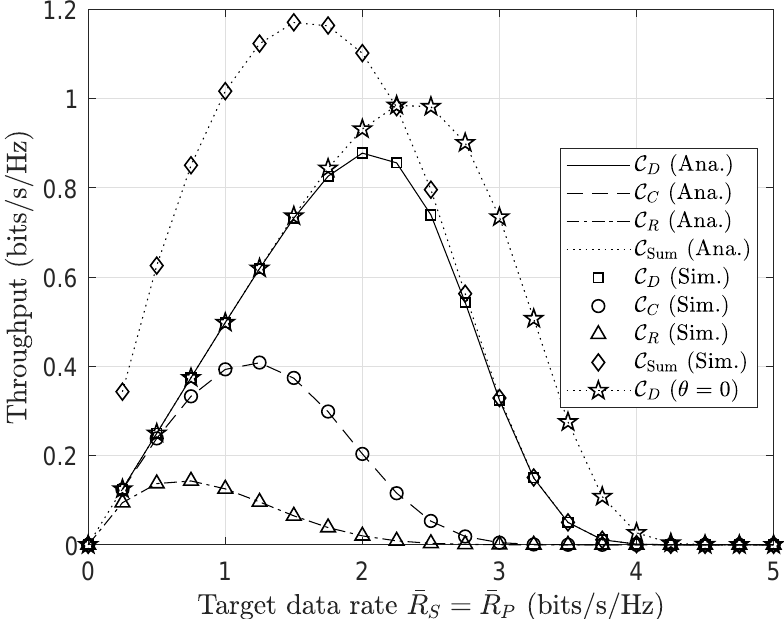
Figure 5. Throughput performance versus the target data rates ¯ R P , ¯ R S